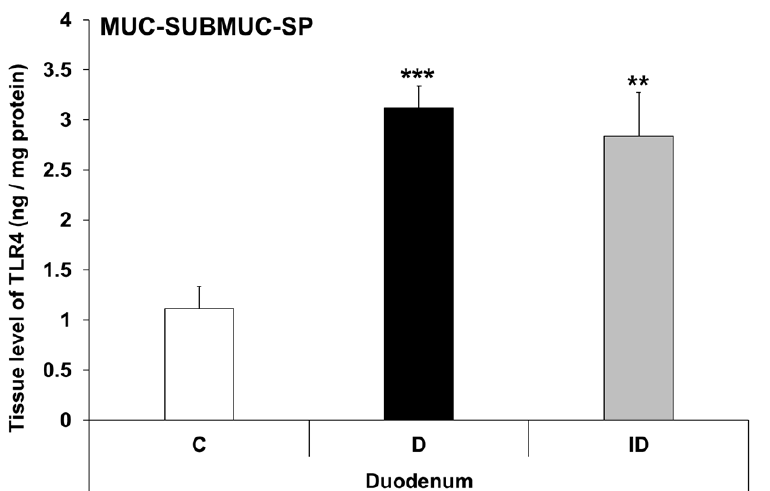
Figure 10. Tissue levels of TLR4 in mucosa and submucosa homogenates, including the submucous plexus, from the duodenum of control, diabetic and insulin-treated diabetic rats. The TLR4 level was robustly increased in diabetic samples of the duodenum relative to controls and was not prevented by insulin replacement. Statistics: Kruskal-Wallis test with Dunn’s multiple comparisons test. Data are expressed as means ± SEM. ** p < 0.01, *** p < 0.001 (relative to controls). C—controls, D—diabetics, ID—insulin-treated diabetics.